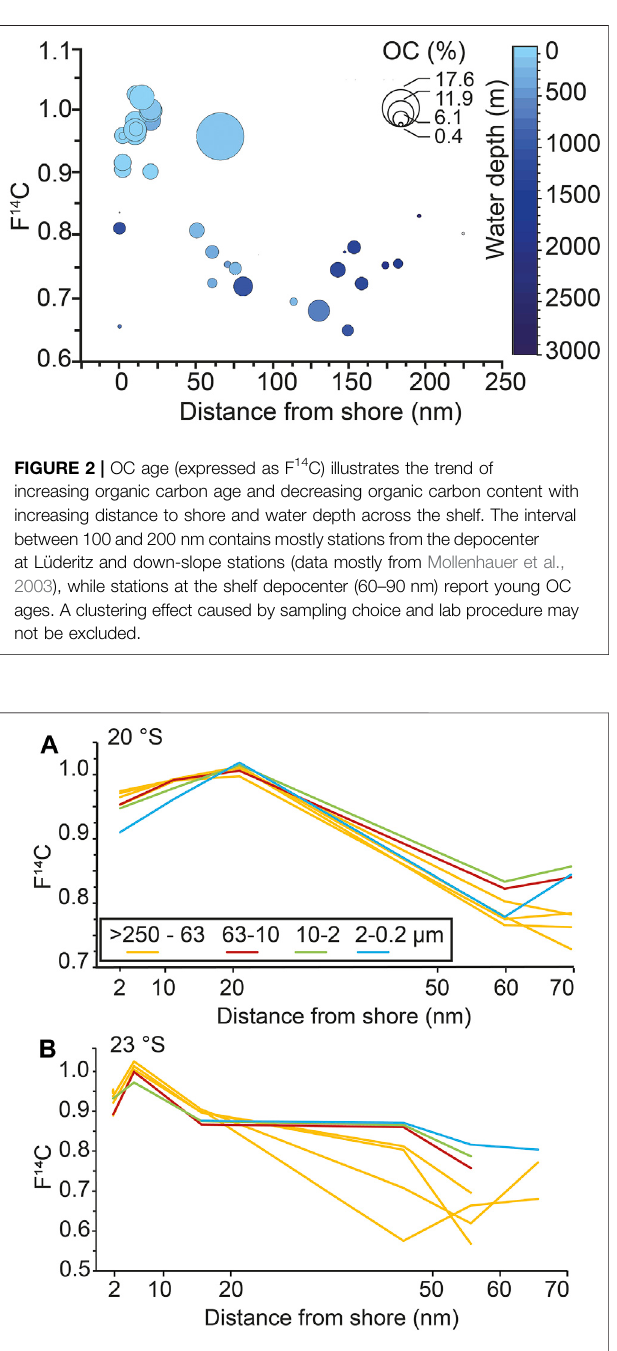
FIGURE 3 | Grain size-speci fi c F 14 C data from the Namibian Shelf from inshore to offshore at (A) 20 ° S and (B) 23 ° S. Inshore stations are generally characterised by younger ages, while sandy grain size fractions contain old organic carbon in the offshore stations. This trend mirrors the offshore ageing trend in the bulk sediment.